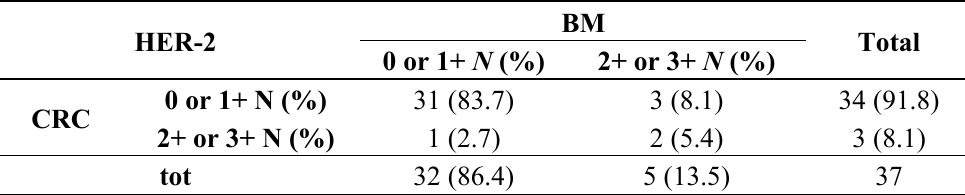
Table 5. IHC HER-2 status concordance between primary tumors and corresponding brain metastases in 37 matched cases *.